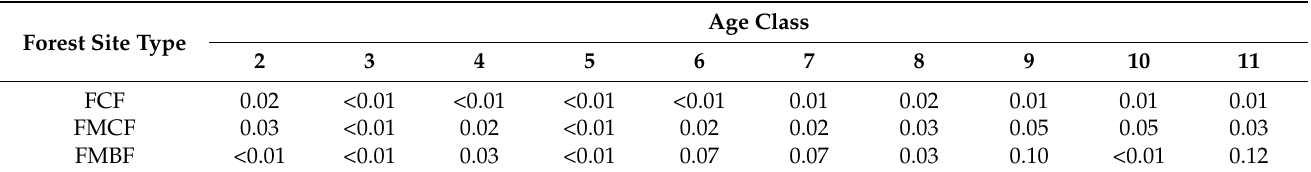
Table 5. R 2 results for the linear relationship between the growing stock volume on the plots and the percentage of edge zones in the forest patches